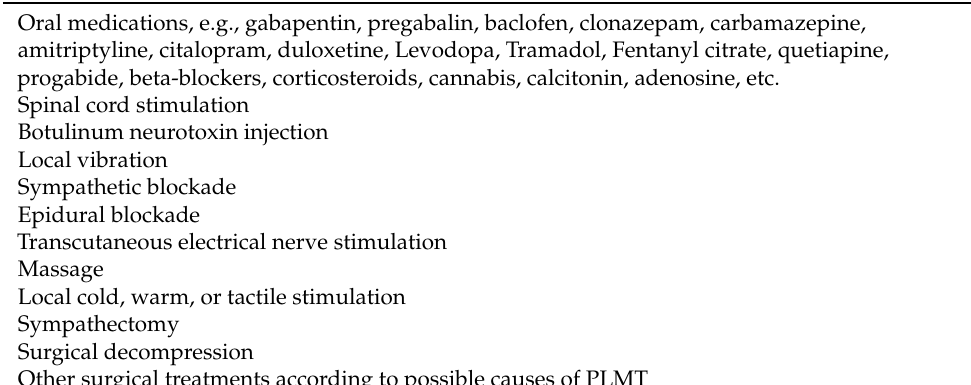
Table 2. Recommended